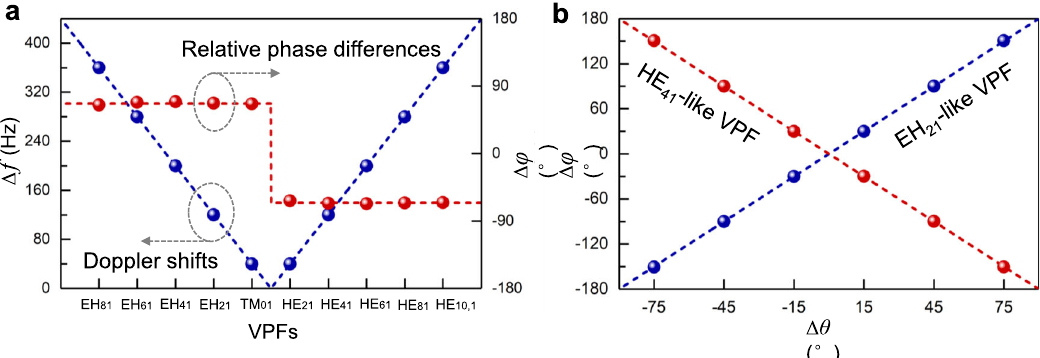
Fig. 4 Measured results for vectorial Doppler effect using cylindrical VPFs with different orders. a Doppler frequency shift and Doppler phase shift versus different orders of cylindrical VPFs (TM 01 , HE 21 , EH 21 , HE 41 , EH 41 , HE 61 , EH 61 , HE 81 , EH 81 , and HE 10,1 ). b Doppler phase shift versus polarizing angle difference between two polarizers used to detect the DPSs. The angular velocity is Ω ¼ (cid:4) 40 π rad/s. The dots represent measured results and the dashed lines denote